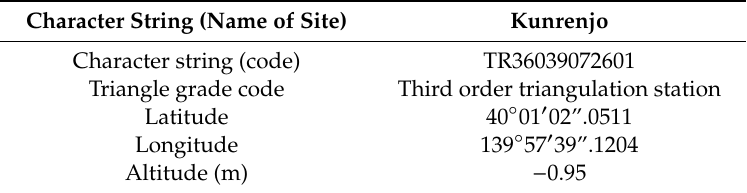
Table A2. Description of the third order triangulation station “Kunrenjo” observed by Geospatial Information Authority of Japan in 1992 [51].